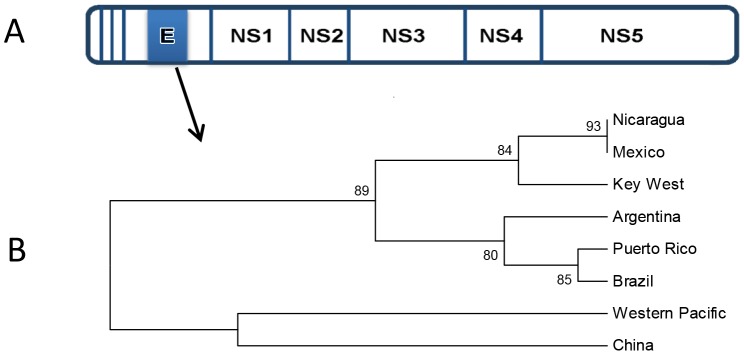
Analysis of recombination events occurring in geographic strains of the DENV-1 viral genome. A. The schematic shows a representation of the genome for the Key West DENV-1 isolate (E = envelope; NS1-5 =  nonstructural regions 1–5). The shaded areas represent the regions where recombination events were identified. B. Phylogenetic tree of DENV-1 sequences in the recombination region (E) from geographic strains of DENV-1 clustered PR with BR and AG.